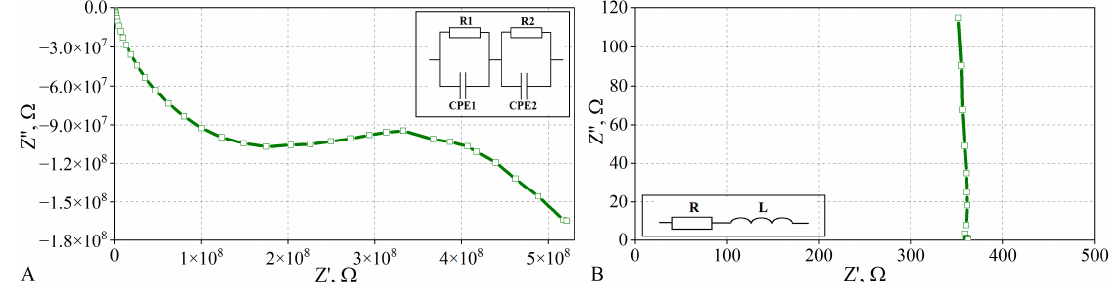
Figure 8. Nyquist plots and adopted equivalent circuits for composites with graphite content of ( A ) 1 wt% and ( B ) 2 wt%.